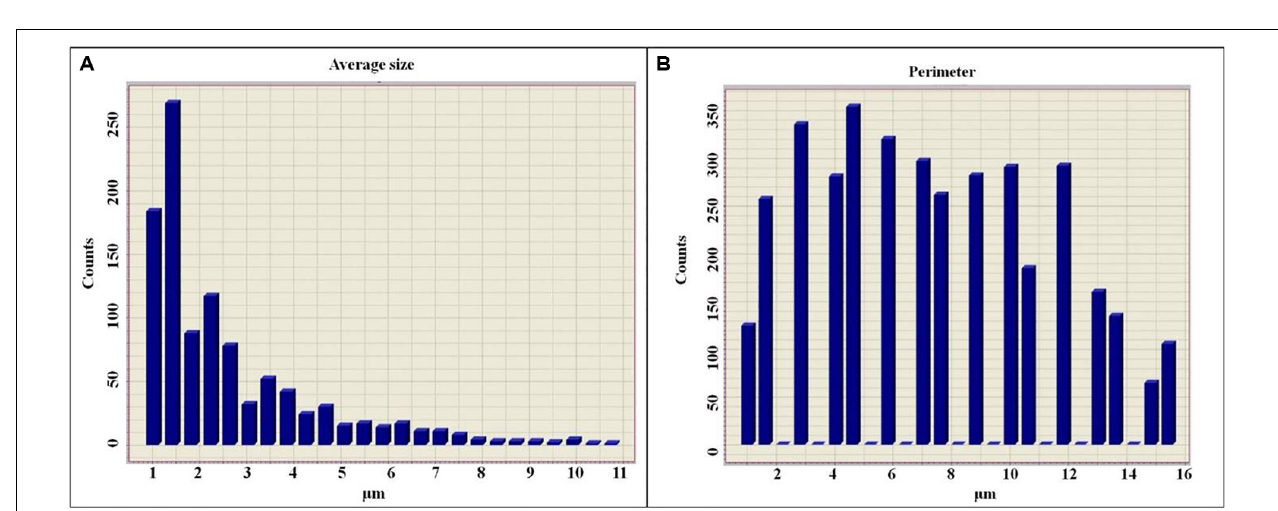
FIGURE 5 | Histogram of the average sizes of colloidal particles of exopolysaccharide (A) , histogram of the perimeters of colloidal particles of a polysaccharide (B) , histogram of the area of colloidal particles of a polysaccharide (C) , histogram of the micrometry of colloidal particles of exopolysaccharides (D) , histogram of the micrometry of colloidal particles of a diluted solution of a polysaccharide (E) .